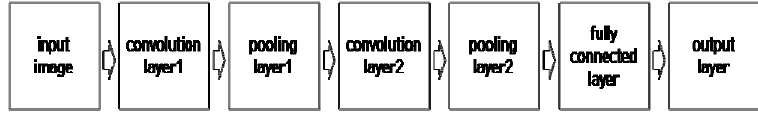
Figure 2. Architecture of convolutional neural network (CNN).